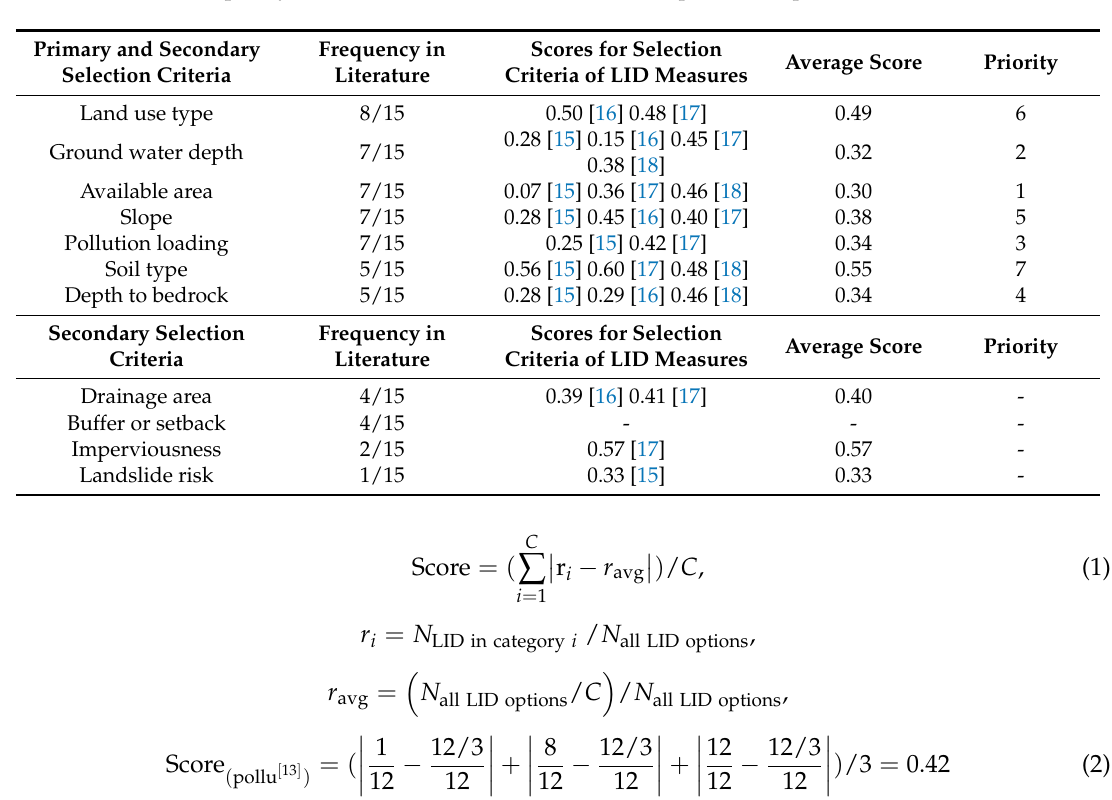
Table 1. Frequency and score for site constraints in low impact development (LID)